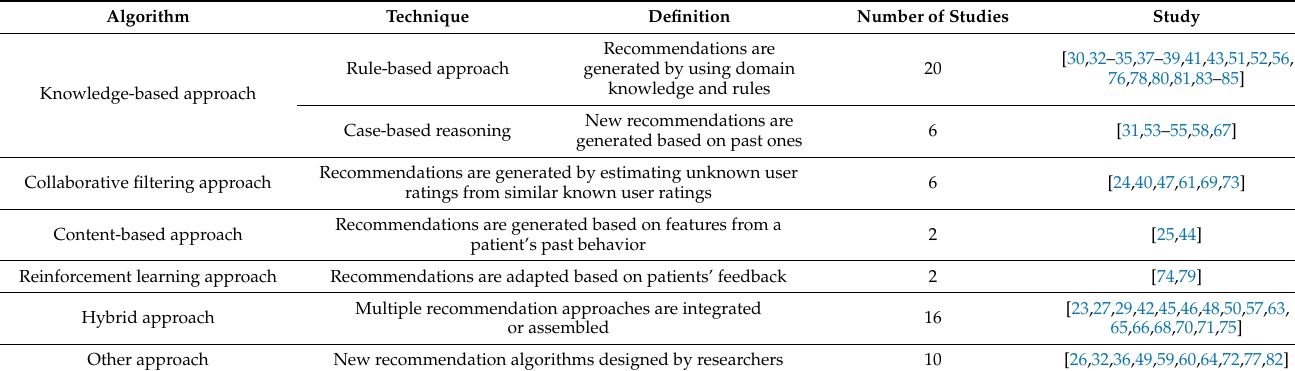
Table 5. The distribution of algorithms in recommendation